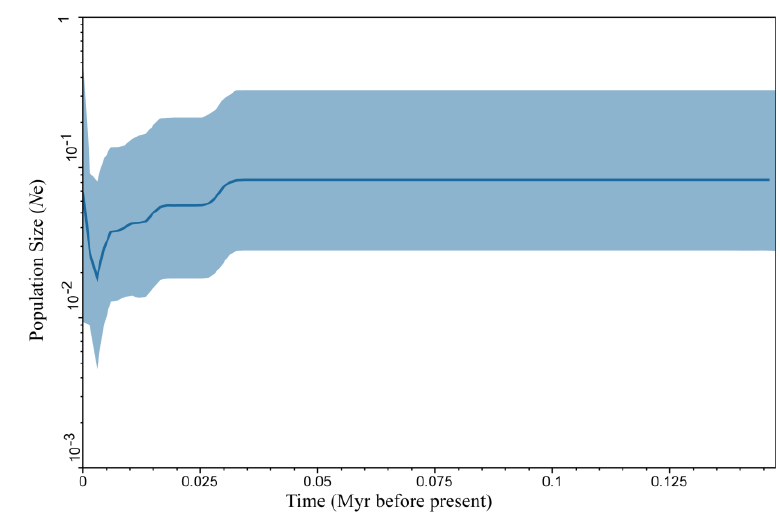
Figure 6. Bayesian skyline plots of population dynamic for populations of A. triastriatus . The shade areas in light blue are within the 95% highest posterior density interval. The dotted vertical lines indicate important population-size changes of A . triastriatus .